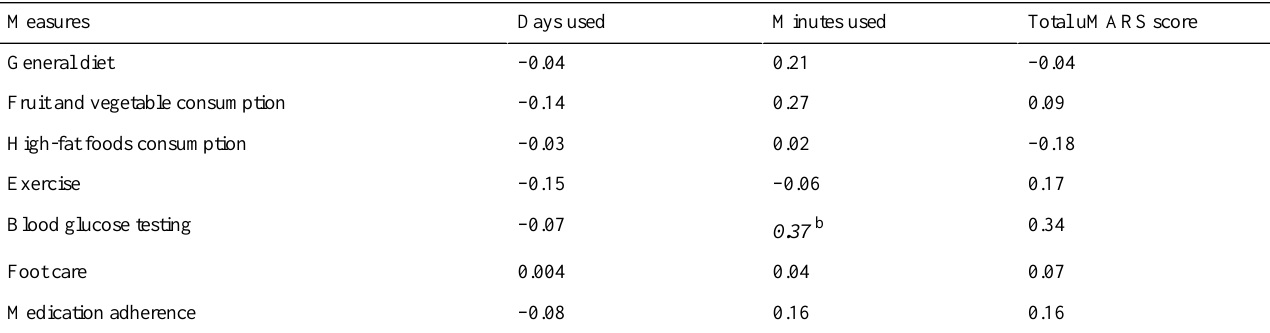
Total uMARS scoreMinutes usedDays usedMeasures